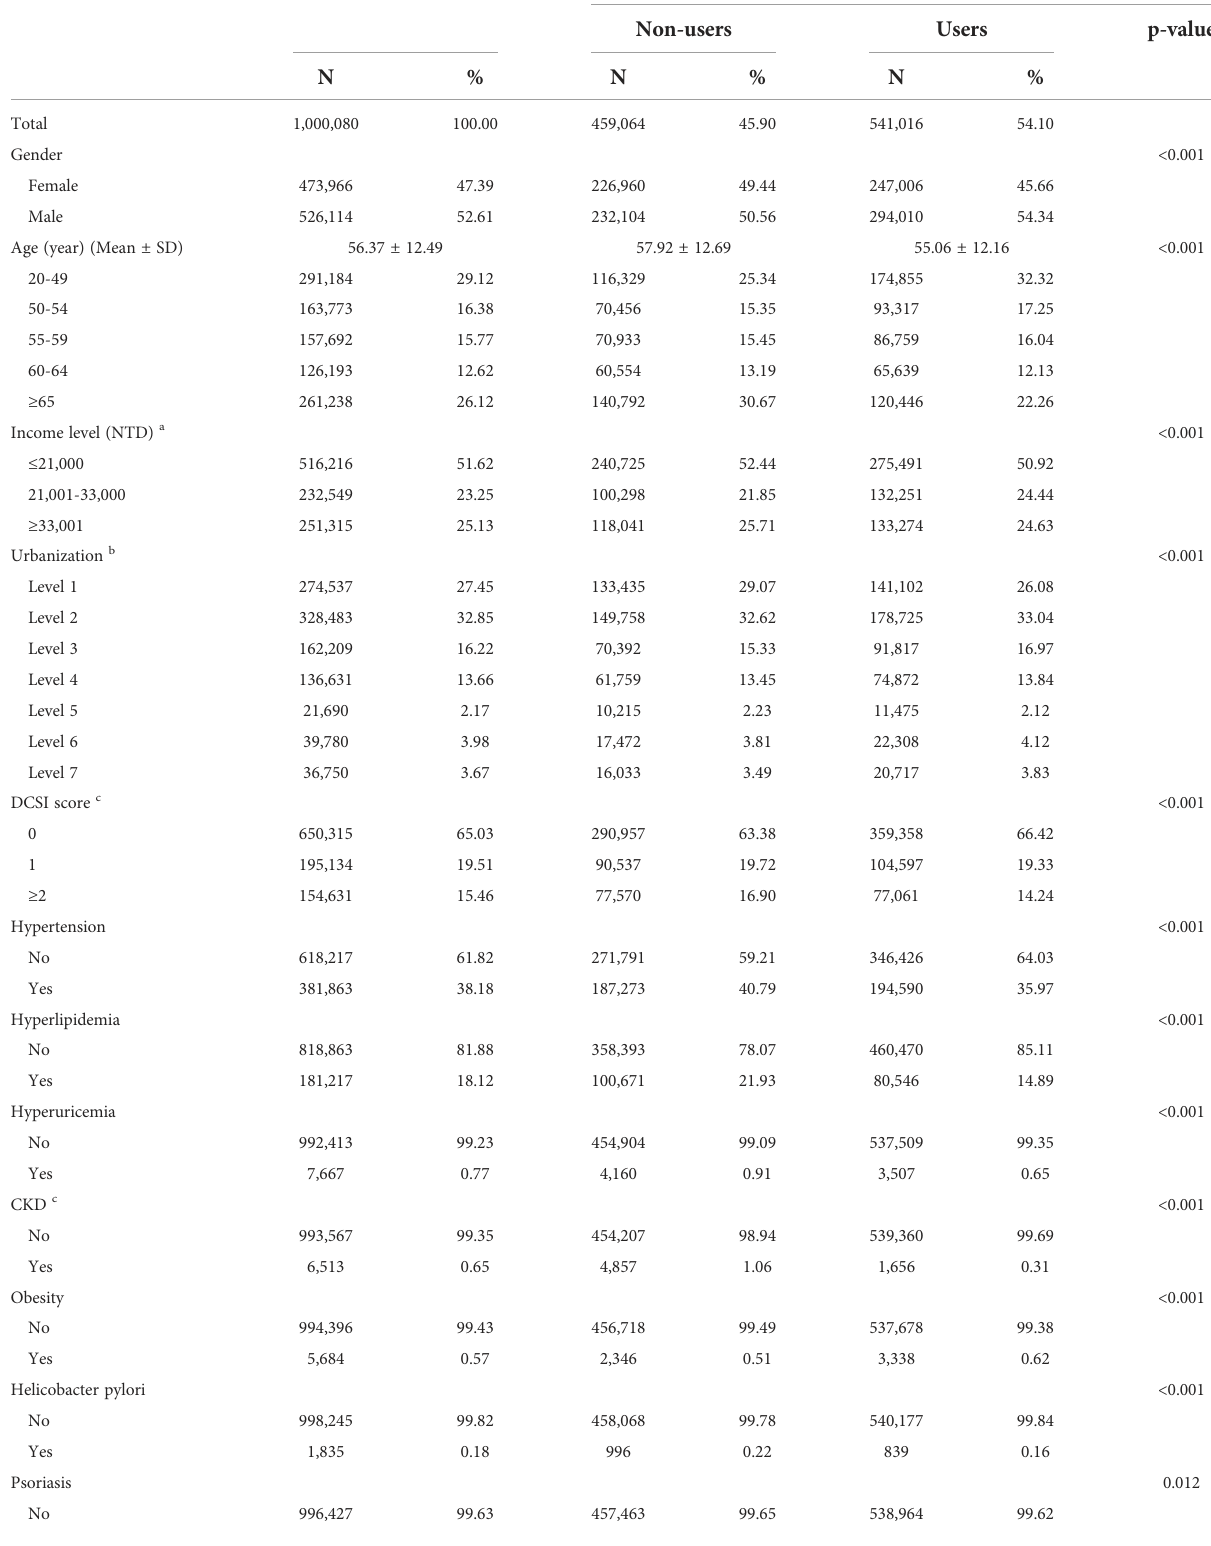
TABLE 1 Baseline characteristics of patients with new-onset diabetes mellitus. Variables